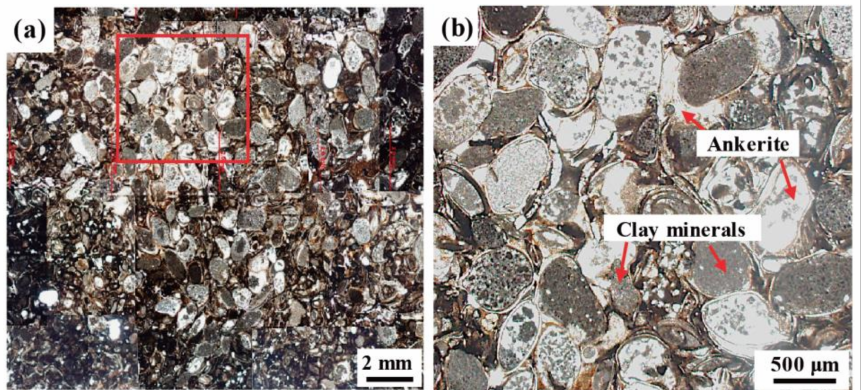
Figure 3. Petrographic features of the studied ostracod layer under transmission light. ( b ) is the enlargement of marked square area in ( a ). The white and gray fillings in the ostracods under transmission light are ankerite and clay minerals,